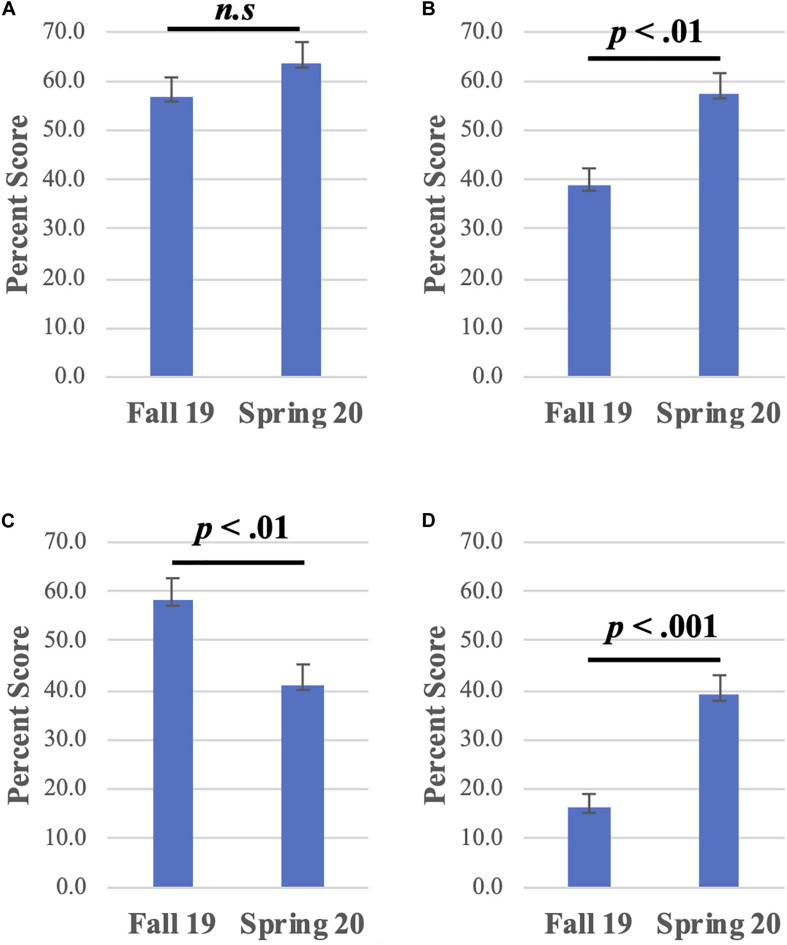
Comparison of exam performance in summative assessment questions for the Fall 2019 and the Spring 2020 cohorts. All graphs compare the mean percentage score and error bars are the standard error of the mean. (A) Question 5a: Protein Secretion, t(177) = –1.20, p = 0.232. (B) Question 5b: Exoenzyme Function, t(177) = –3.24, p = 0.001. (C) Question 5c: Nutrient Transport, t(177) = 2.63, p = 0.009. (D) Question 5d, Metabolism, t(177) = –4.68, p < 0.00001. Bar graphs display the responses for Fall 2019 (n = 89) and Spring 2020 semester (n = 90). All statistics are unpaired, two-tailed, Student’s t-Tests. For details on the questions and their answers, please see the Supplementary Material.